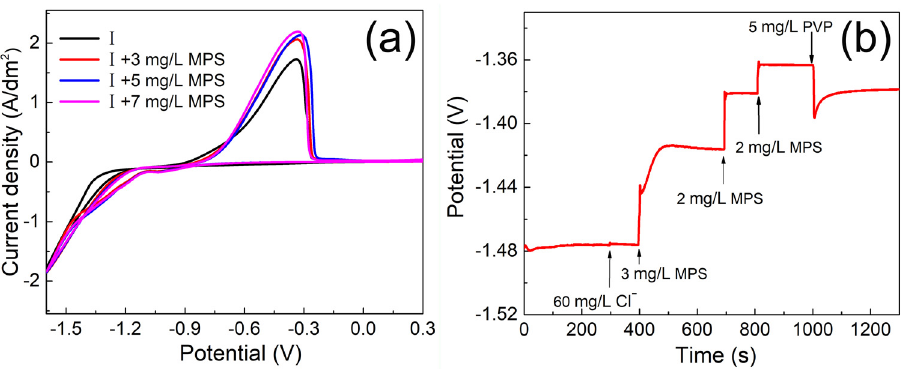
Figure 1: CV plots of cobalt plating solutions with MPS ( a ) Time – potential curve with the addition of PVP and MPS ( b ) . The basic solution in ( a ) contains 0.3 mol/L CoSO · 7H · 6H 4 2 O, 0.84 mmol/L CoCl 2 2 O and 0.57 mol/L H 3 BO 3 . The basic solution in CoSO 4 · 7H 2 O and 0.57 mol/L H 3 BO 3 .